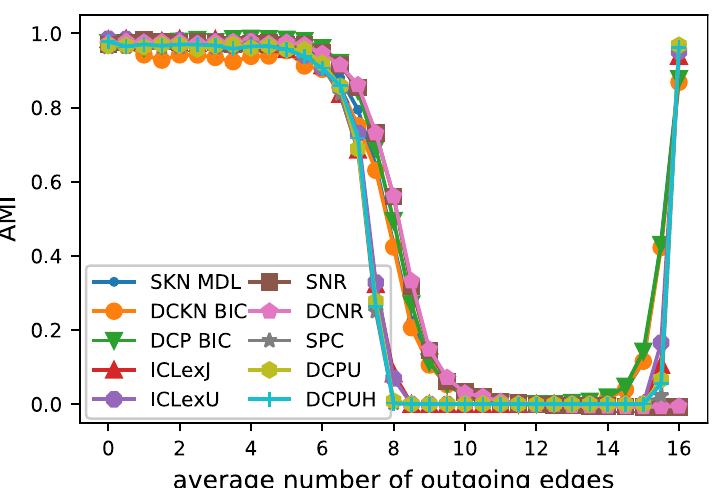
Fig 8. Results of Girvan-Newman test with model selection. Like before, we used 10 network instances for each k out . For each network and each SBM variant we executed the MHA 50 k 10 times for each K = 1, ... , 10. Then we considered one execution for each network for all number of group K 2 {1, ... , 10} as one unit and executed the model selection based on these results. Therefore, a data point is the average of 100 AMI values resulting from the 10 network instances and the 10 selected partitions. For the classic models only the best model selection according to Table 2 is shown.